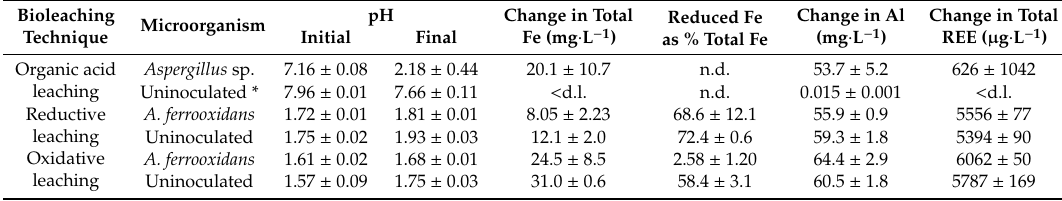
Table 7. Changes in pH, iron, aluminium and TREE concentrations and percentage of reduced iron in final solutions for high-Ca bauxite during organic acid, reductive and oxidative leaching and uninoculated controls, recorded after 1 h and then at the end of 7 days of leaching. The initial pH for reductive and oxidative leaching was measured after the addition of H 2 SO 4 . This was required in order to reduce the pH to within the growth range for A. ferrooxidans , following pH increase caused by carbonate dissolution. Characterisation of starting fluid conditions is shown in Table 3. Errors are one standard deviation of triplicate experiments.